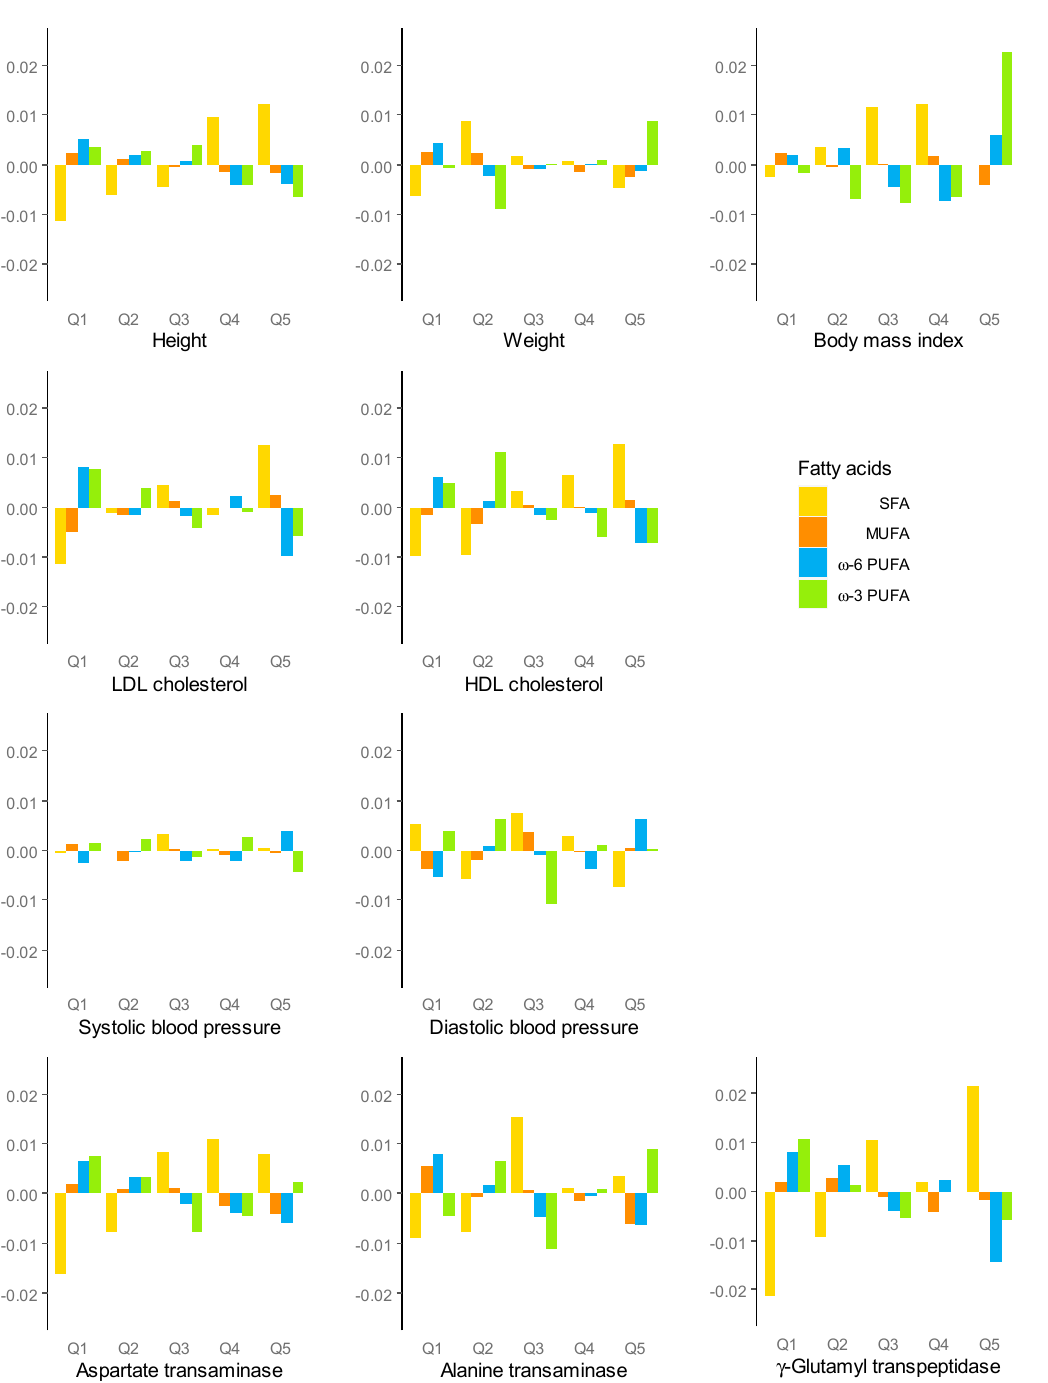
Figure 2. Centered log-ratios of dietary fatty acids. In each quintile category of cardiometabolic risks (Q1–Q5), a log-ratio of each geometric mean for fatty acids to overall geometric mean across all subjects, which was centered among the five categories, was plotted. A positive bar indicates a relative mean value of the fatty acid above the overall mean composition across the five categories, and a negative bar indicates a relative mean value below the overall mean.